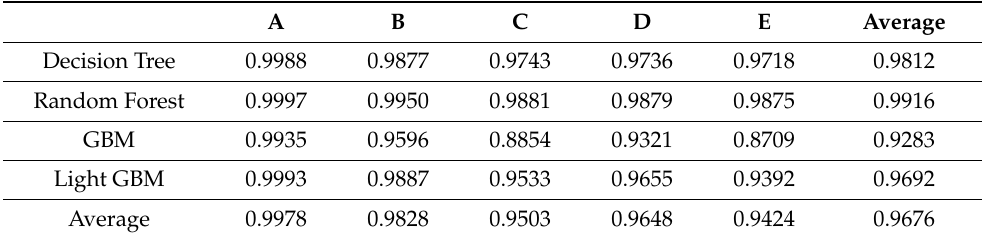
Table 8. The average classification accuracy between the standing and moving acts by the ML-based analysis model. A B C